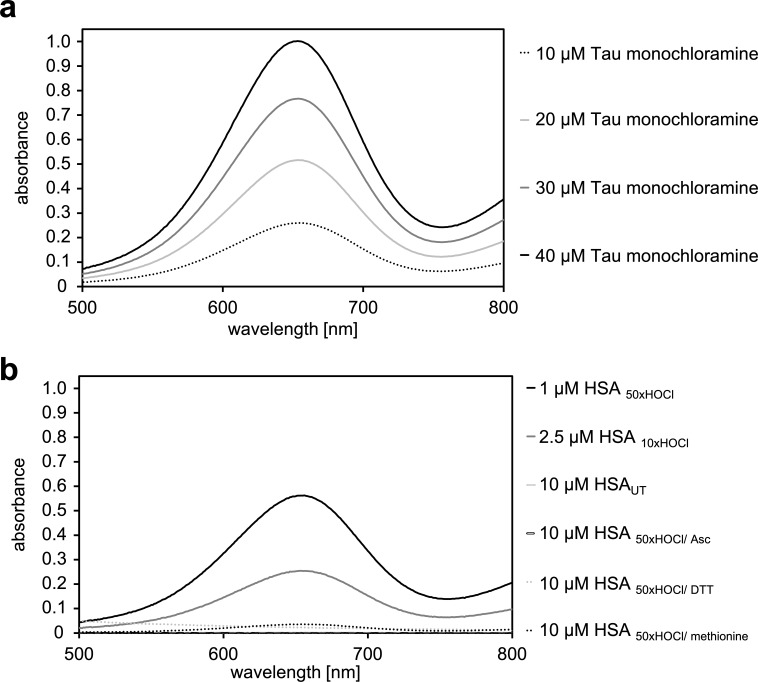
Determination of the N-chloramine content of HOCl-treated HSA.(a) Measurement of the standard curve using known concentrations of taurine monochloramine. The standard curve is shown in Figure 3c in the main manuscript. (b) Determination of the content of chloramines in HSA treated with HOCl at different concentrations and reductants as indicated. Bar graph representation of this data is shown in Figure 3d in the main manuscript. Representative measurements shown. Data represented as means and standard deviations from three independent experiments found in Figure 3c and d in the main manuscript.
10.7554/eLife.47395.020Figure 3—figure supplement 1—source data 1.Numerical fluorescence spectroscopy data obtained during determination of protein chloramines represented in Figure 3—figure supplement 1.